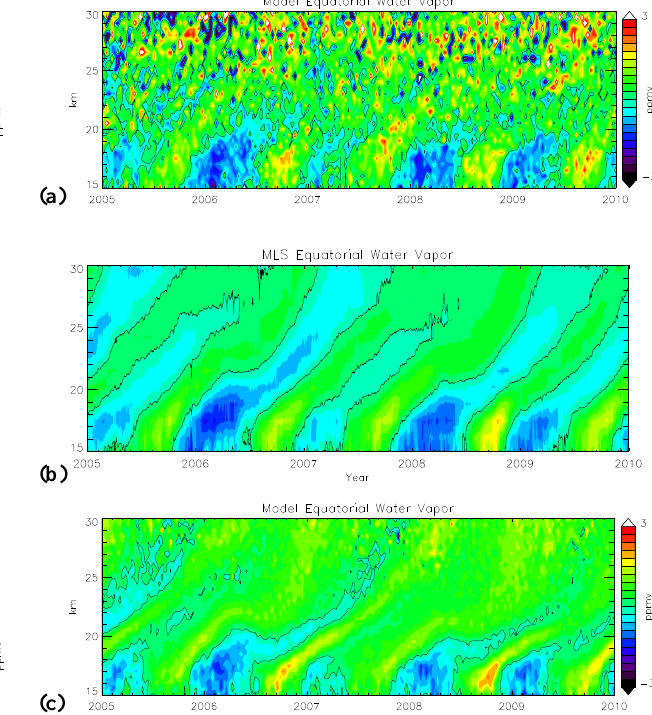
Fig. 7. Water vapor concentration anomalies at the equator ( ± 1 ◦ ) vs. time. (a) K120 (kinematic) experiment, (b) MLS V3 observa- tions. Missing MLS data is interpolated over the gaps. (c) D104 (diabatic) experiment (see Table